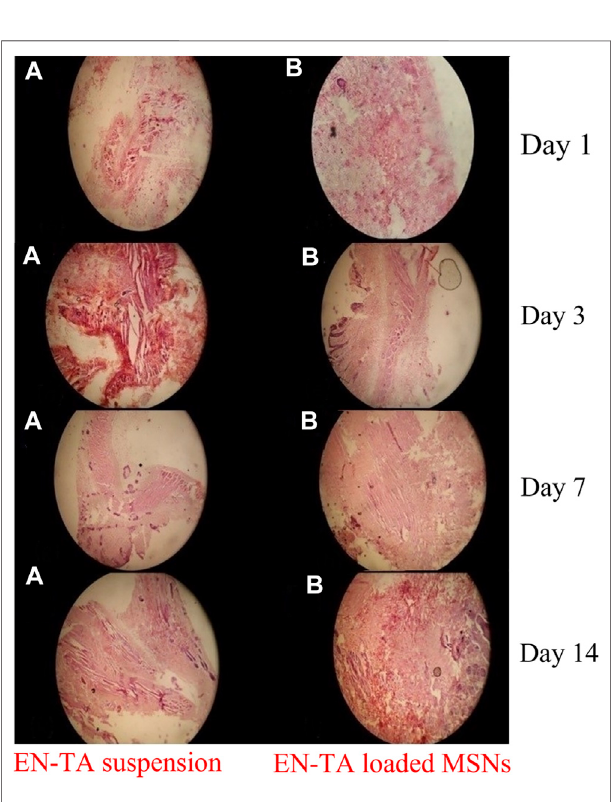
FIGURE 8 | Histopathological changes in pure EN-TA suspension treated control group-I and in EN-TA loaded optimized MSNs treated group-II on day-1, day-3, day-7, and